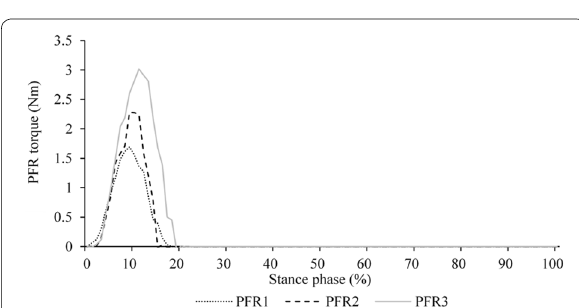
Fig. 8 PFR torque in stance phase. The % stance phase means time normalized to stance phase, from heel contact to toe off